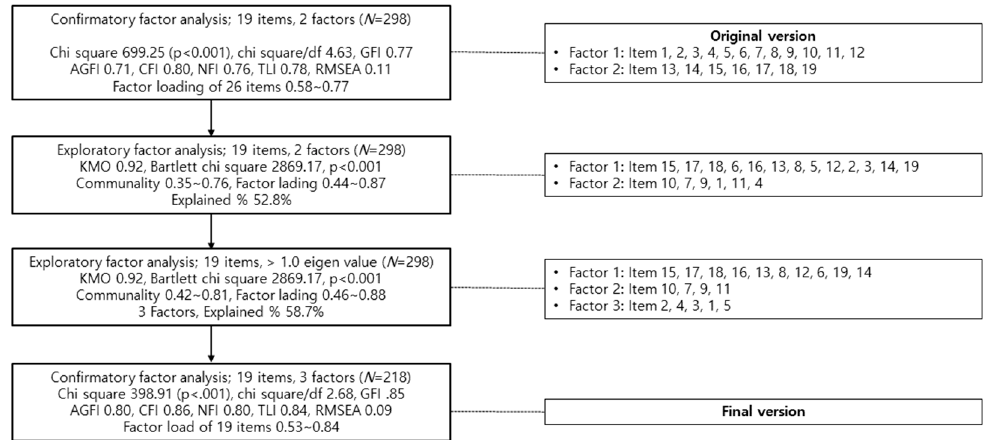
Figure 1. Flow of factor analysis. AGFI = Adjusted Goodness of Fit Index; CFI = Goodness of Fit Index; KMO = Kaiser–Meyer–Olkin; NFI = Normed Fit Index; RMSEA = Root Mean Squared Error of Approximation; TLI = Tuker–Lewis index